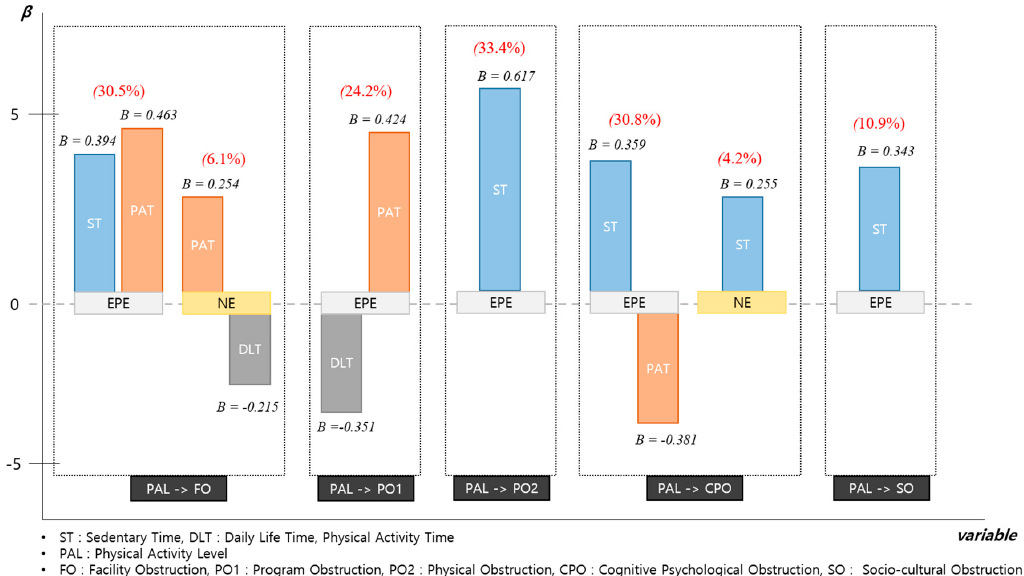
Figure 2. Hierarchical regression analysis for the effects of the physical activity levels and obstruction factors based on the physical activity participation experience.